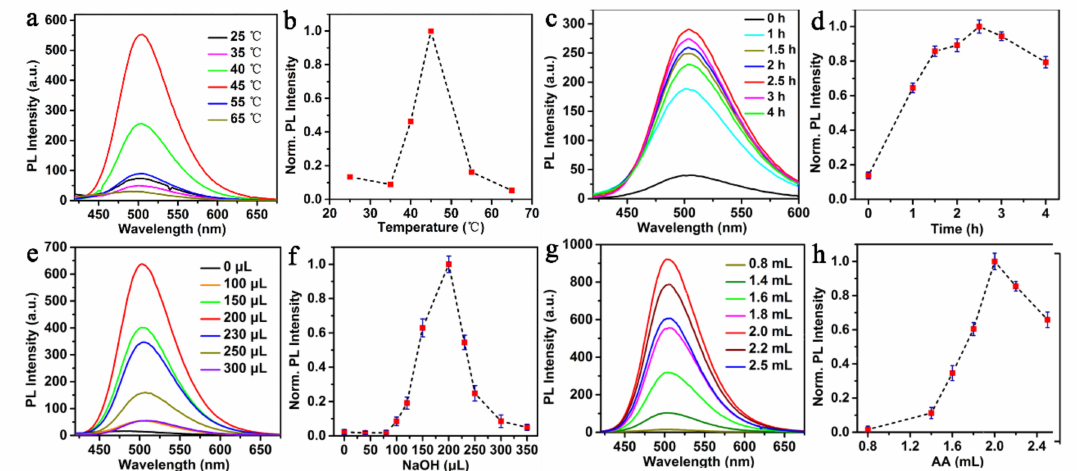
Figure 6. ( a ) Emission spectra of Cu NCs@AA finally obtained at di ff erent incubation temperatures. ( b ) The trend line of normalized photoluminescence intensity (PL). ( c ) Emission spectra of Cu